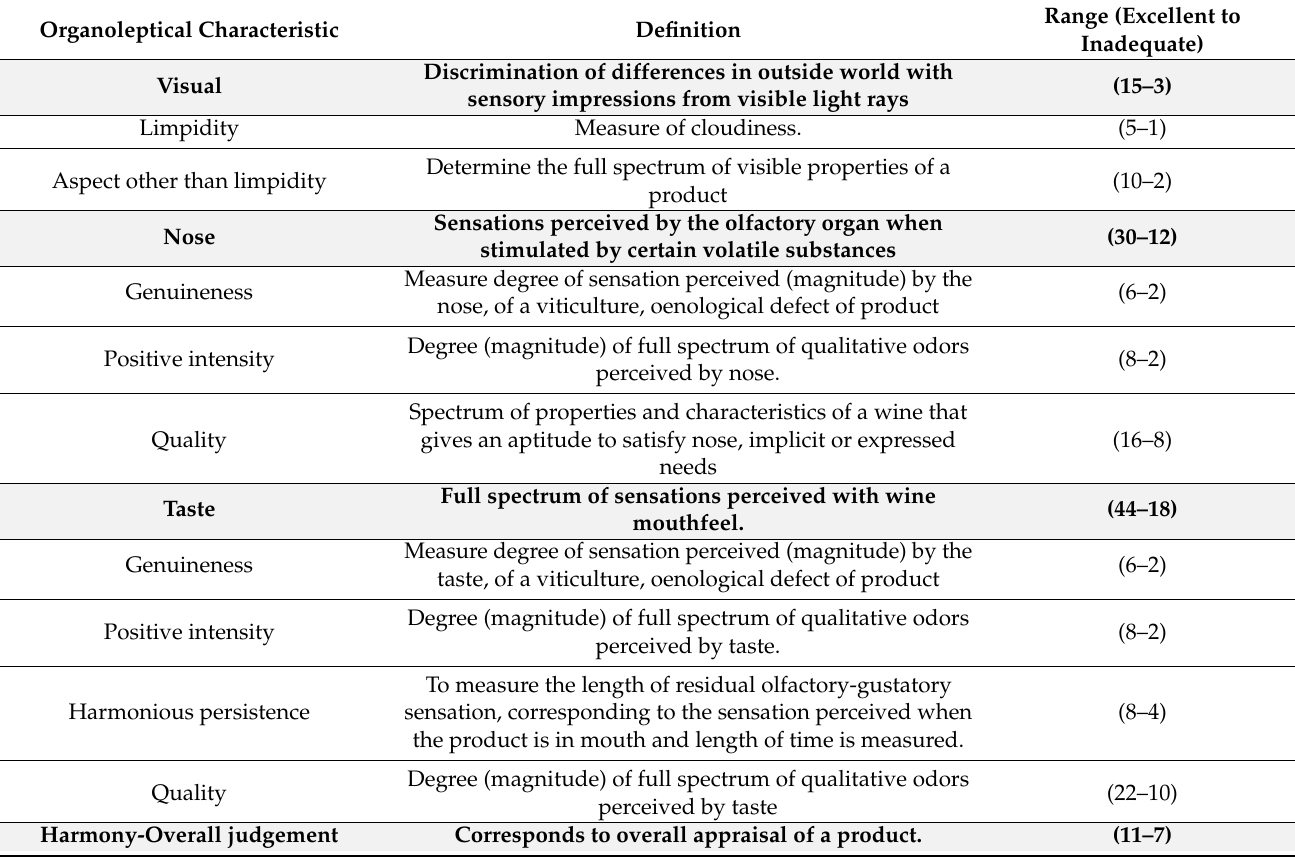
Table 2. Organoleptical characteristics and definitions used in sensory